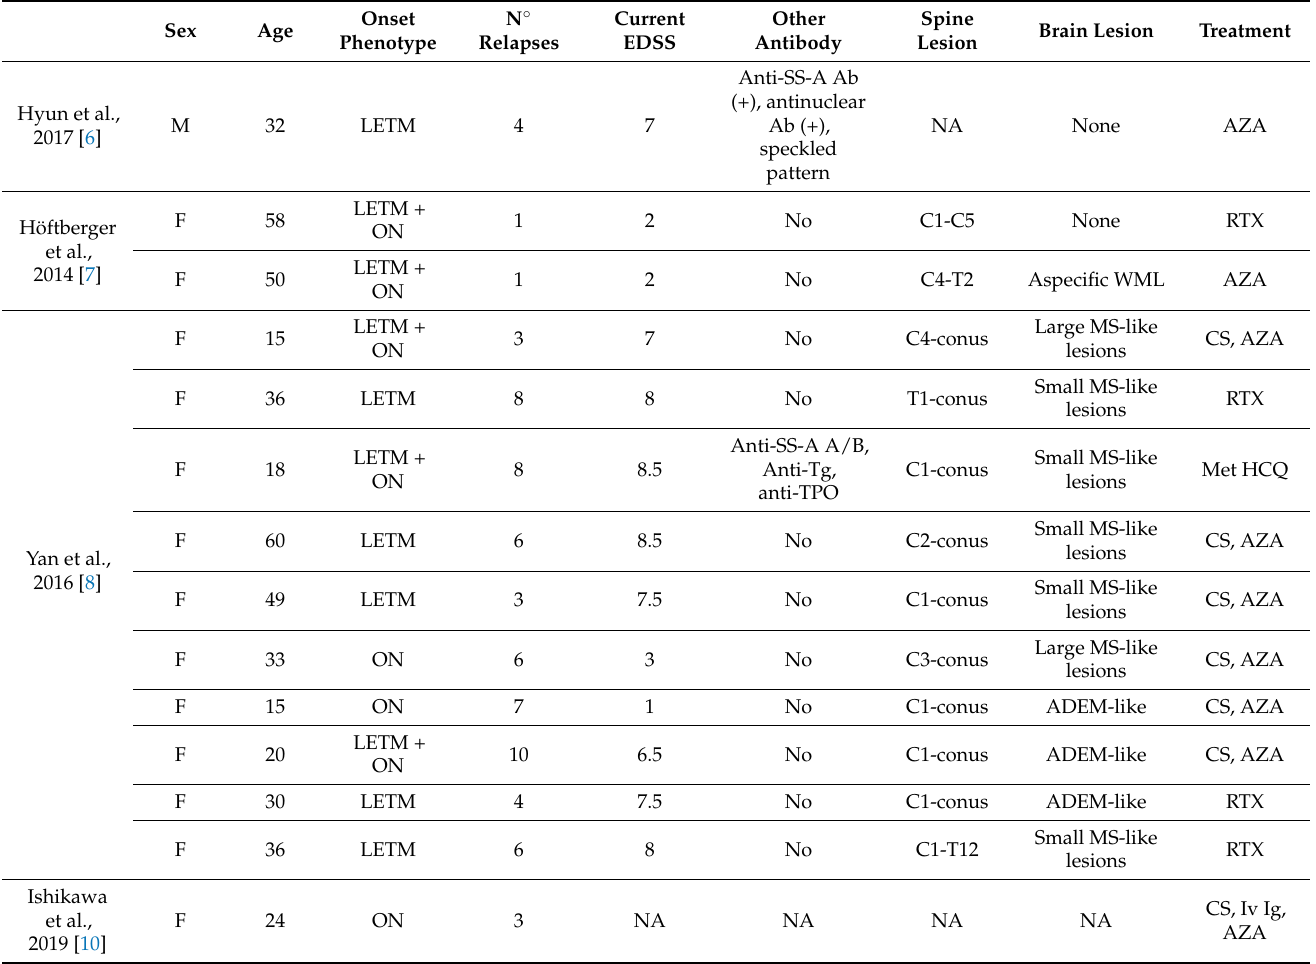
Table 1. Review of available case